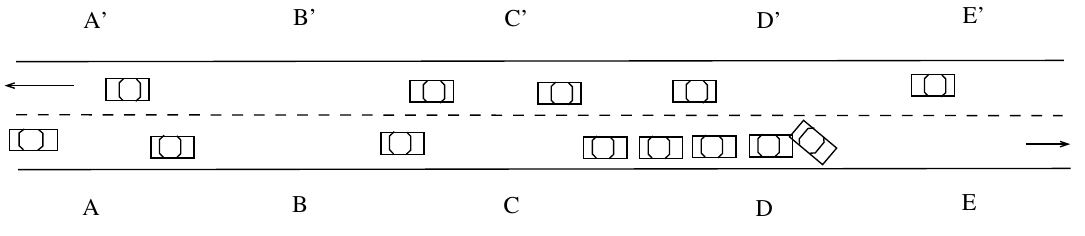
Figure 7. Illustrating time-critical information dissemination on a two-lane